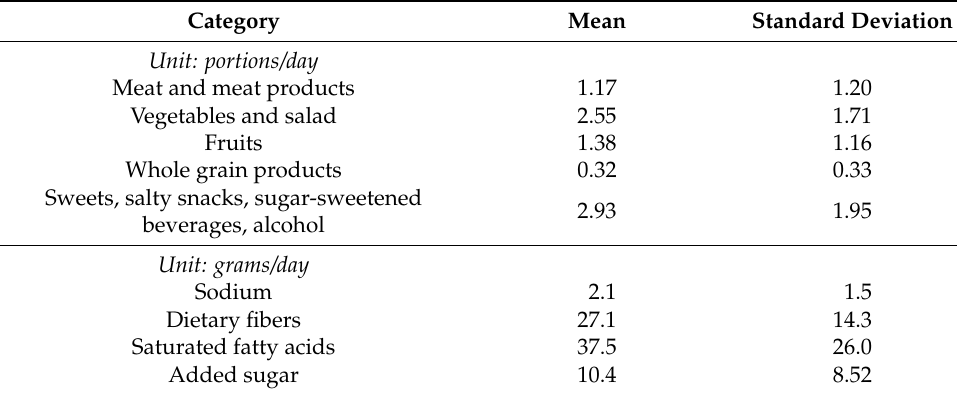
Figure 4. Web-mediated food frequency questionnaire (FFQ). Table 1. Absolute individual daily nutritional intake, N =